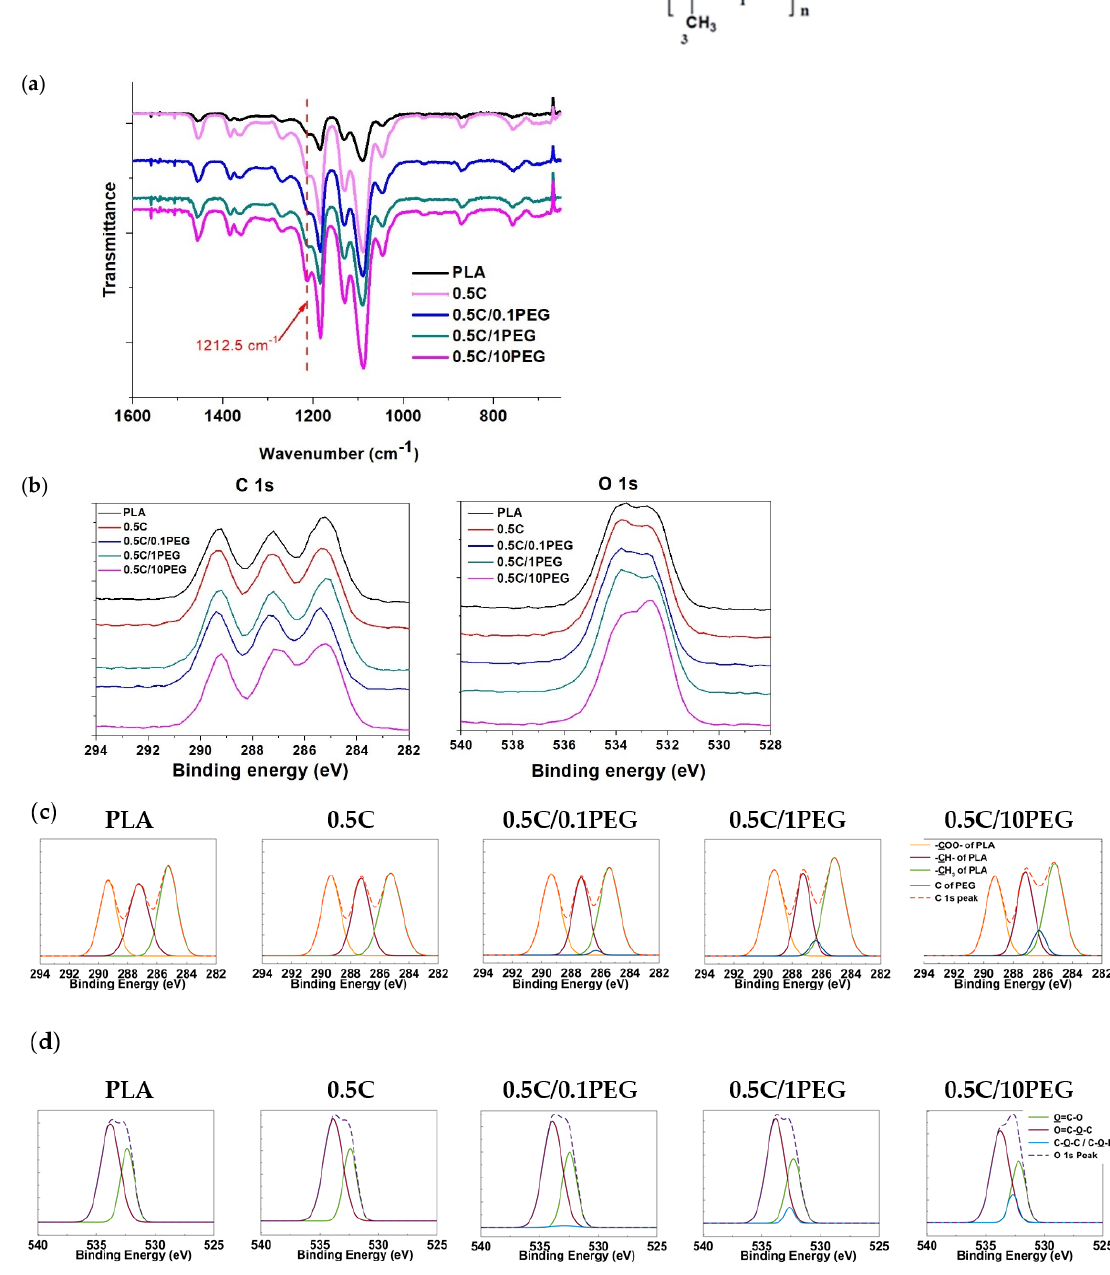
Figure 3. ( a ) The FT-IR spectra of nanofibers. The adsorption of 1212.5 cm − 1 is the specific peak PEG due to its stretching vibration of C–O in the terminal of PEG chains. ( b ) The XPS spectra of nanofibers. The C 1s peak and O 1s peak are at 284~291 eV and 532~536 eV, respectively. ( c ) The C 1s (dashed line) can be resolved into 4 peaks, and ( d ) the O 1s (dashed line) are resolved into 3 peaks, which can be applied to distinguish the PLA and PEG (blue lines) components.